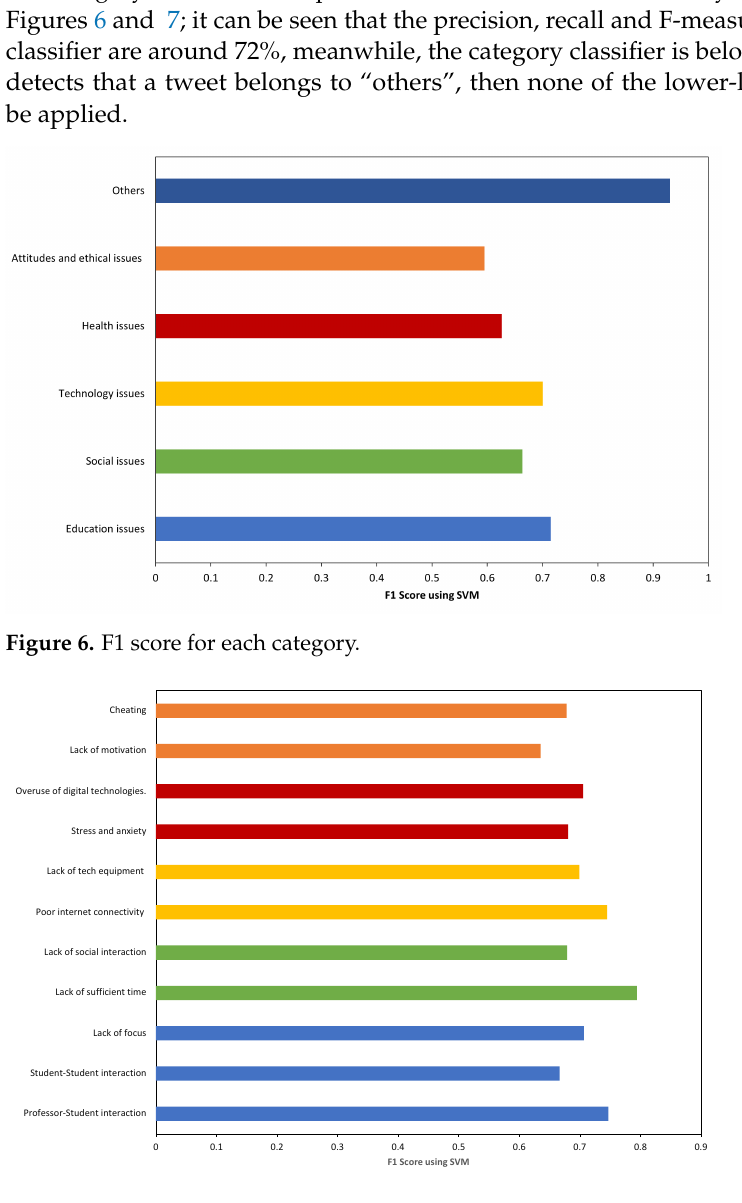
Figure 7. F1 score for each